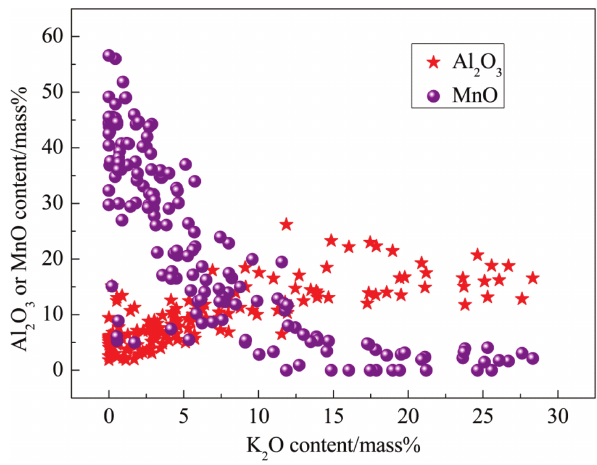
Figure 7: Change of Al 2 O 3 and MnO with the increase of K 2 O in different inclusions (Heats b through e).